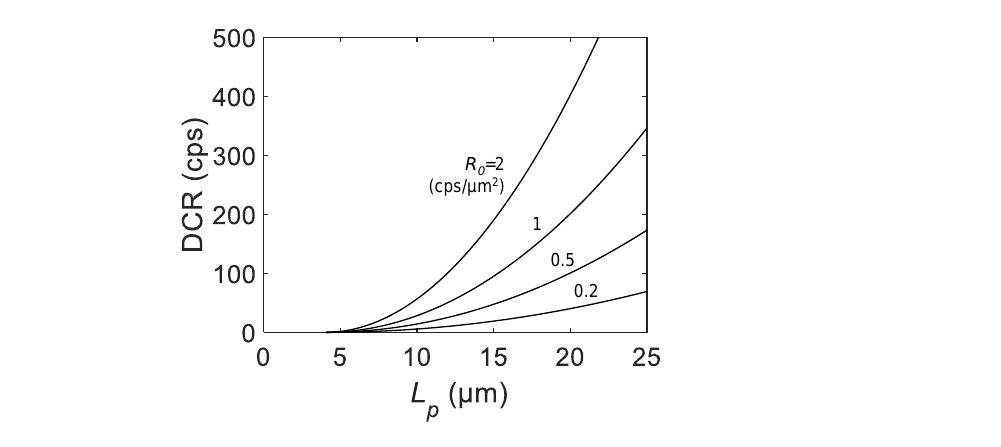
Figure 5. The calculated DCR as a function of the SPAD pixel pitch L p for R 0 = 0.2, 0.5, 1, and 2 cps/ µ m 2 , active-to-active distance L a − a = 3 µ m and inactive radius r in = 0.5 µ m.